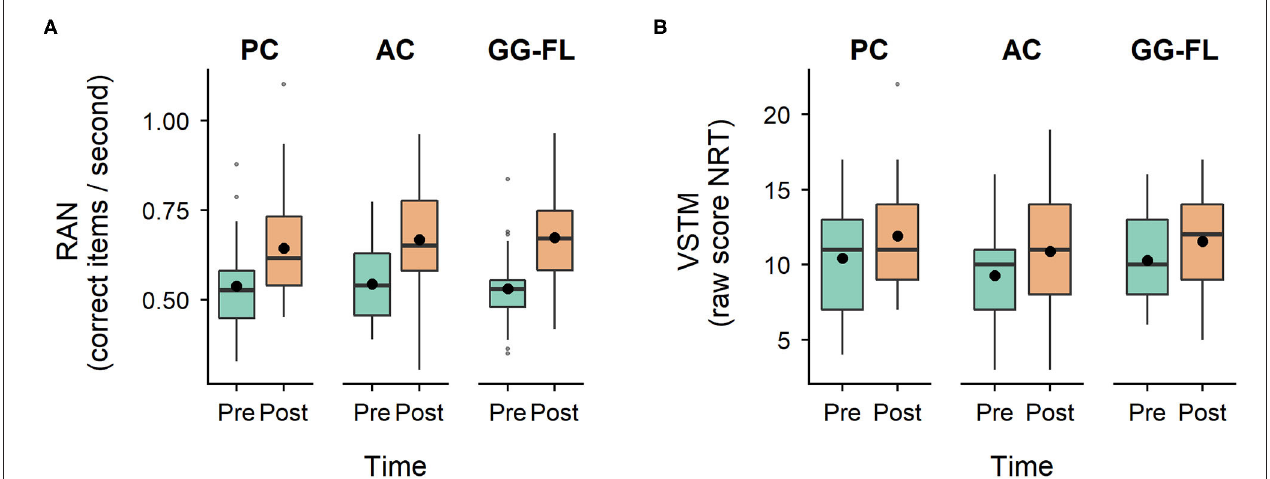
FIGURE 6 | Non-specifically trained phonological abilities. (A) , Distribution of rapid automatized naming scores across groups and timepoints. (B) , Distribution of verbal short-term memory scores across groups and timepoints. RAN, rapid automatized naming; VSTM, verbal short-term memory; NRT, non-word repetition task; PC, passive control group; AC, active control group; GG-FL, GraphoGame Flemish group. Black dots represent the mean of the raw scores.